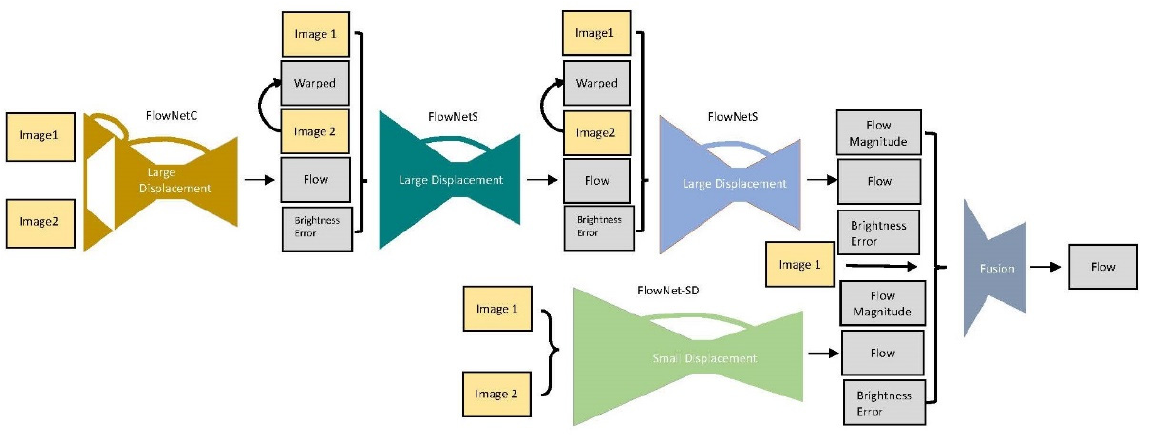
Figure 4. Concatenated network of FlowNet2.0.